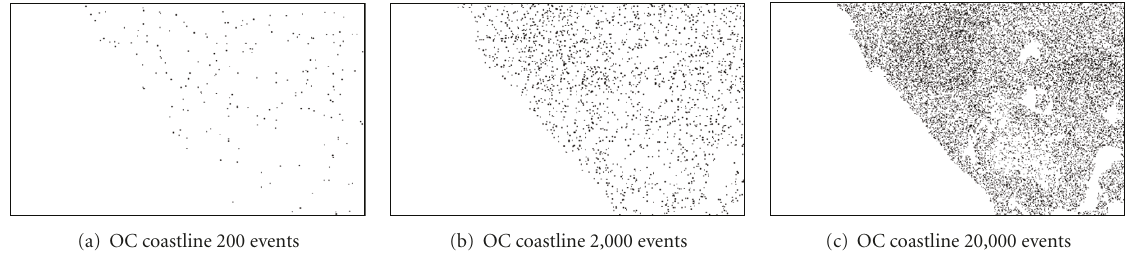
Figure 6: From the probability density in Figure 5, we sampled 200, 2,000, and 20,000 events. These events are given in (a), (b), and (c), respectively.